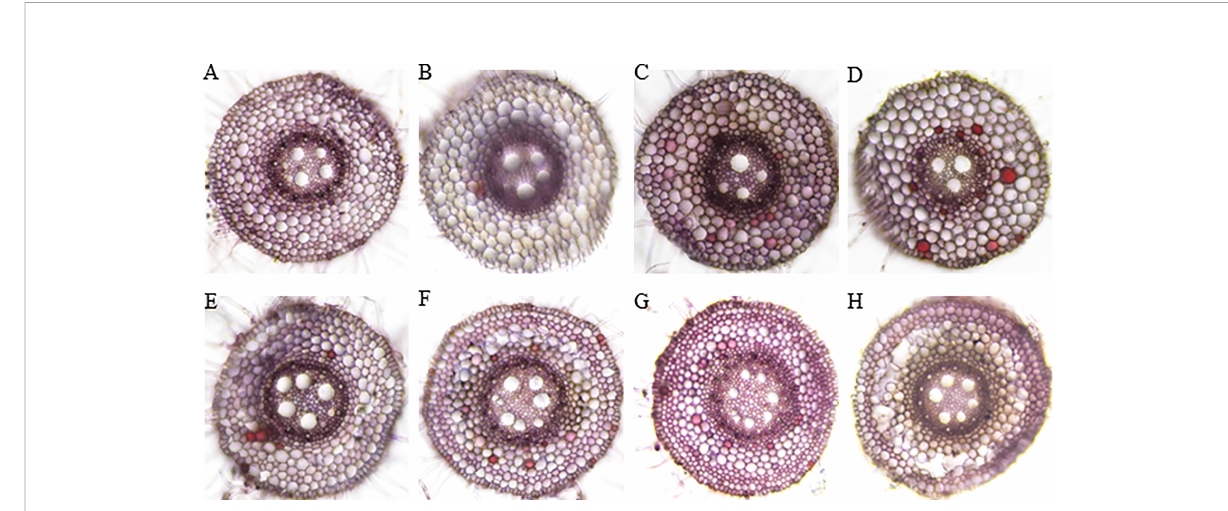
FIGURE 7 Neutral red staining for cell acidi fi cation. Upper panel: H-195; Bottom panel: H-242. (A, E) , (B, F) , (C, G) , and (D, H) : waterlogging for 1 to 4 d,